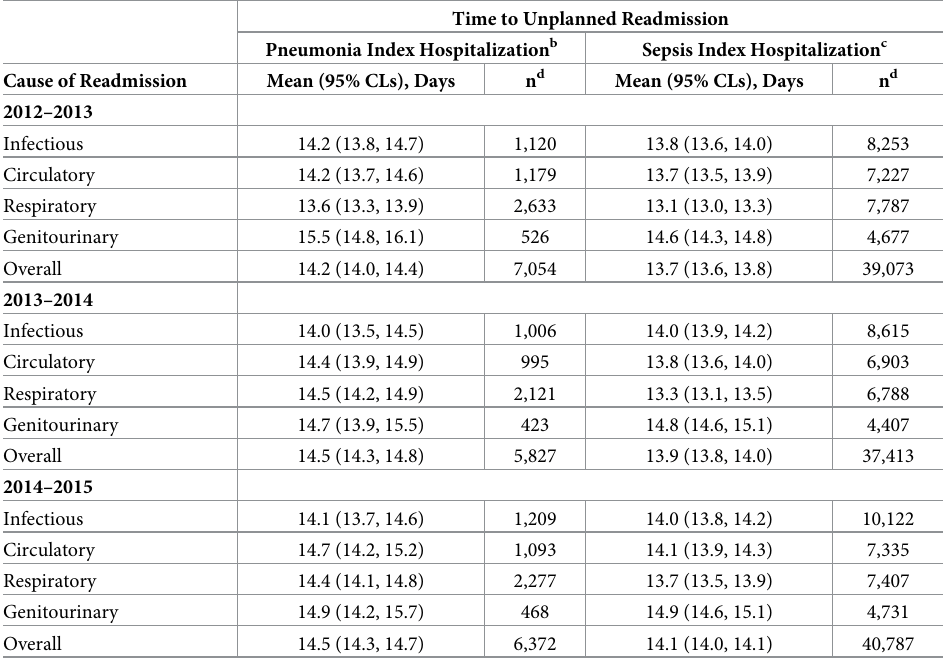
Table 4. Time to 30-day unplanned hospital readmission among older adults discharged to skilled nursing facili- ties following an index hospitalization for pneumonia or sepsis, 2012–2015 a